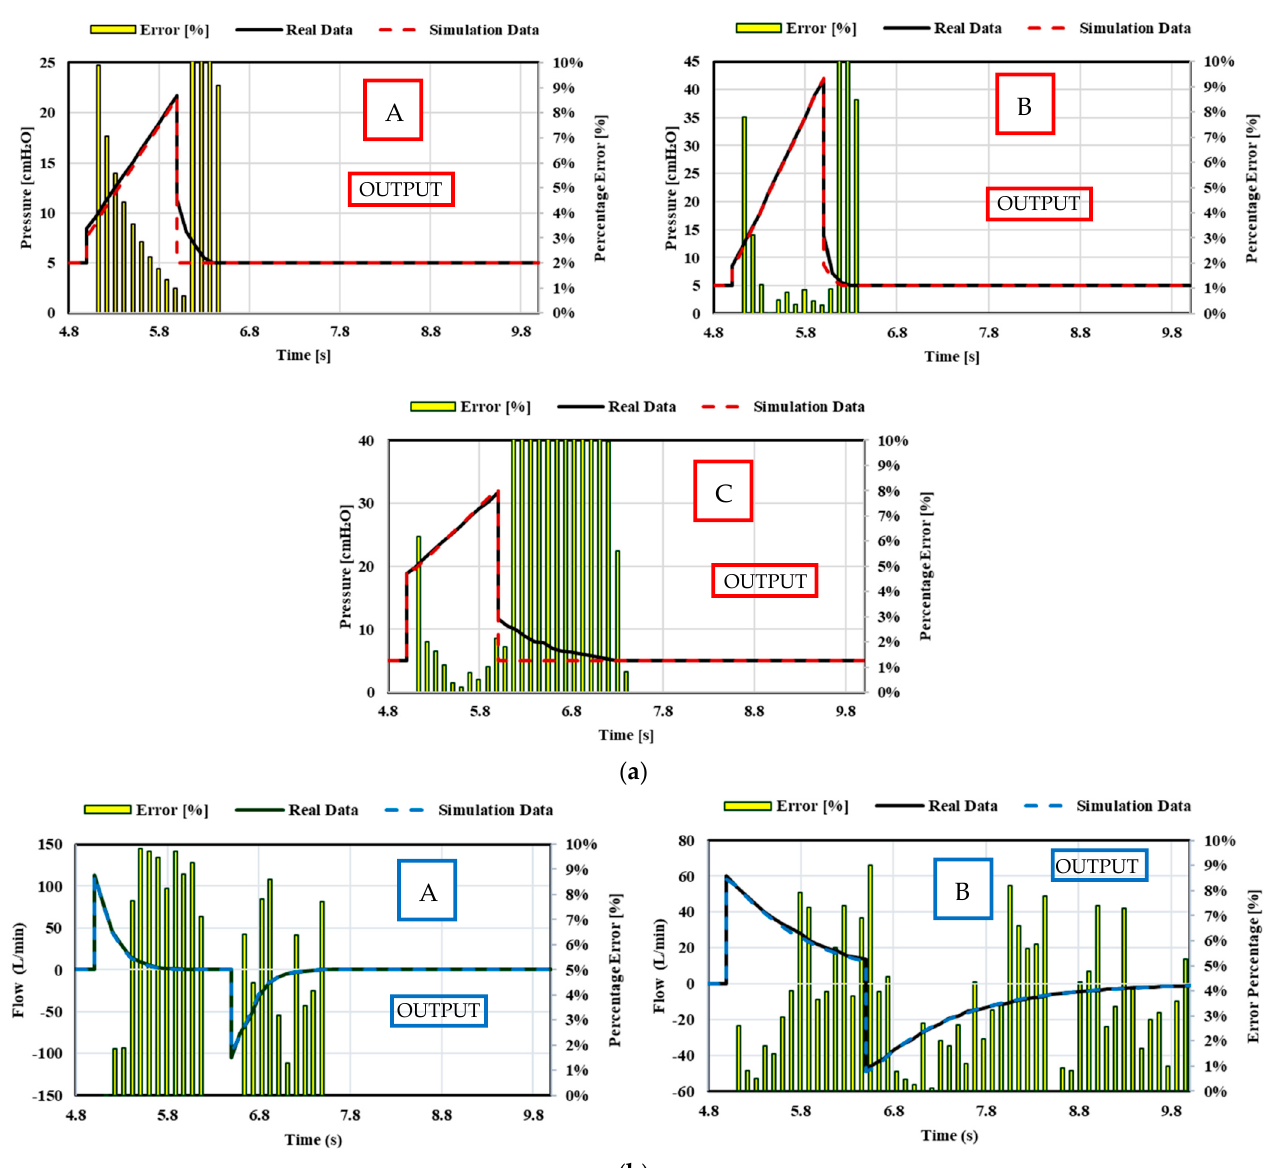
Figure 27. Case 3. Comparison between theoretical real-life data and simulation data for the resistance and compliance changes: ( a ) VC-CMV mode ([A] C RS = 0.05 L/cmH 2 O, R insp = 5 cmH 2 O/L/s, R exp = 15 cmH 2 O/L/s; [B] C RS = 0.02 L/cmH 2 O, R insp = 5 cmH 2 O/L/s, R exp = 15 cmH 2 O/L/s; [C] C RS = 0.05 L/cmH 2 O, R insp/exp = 20 cmH 2 O/L/s); ( b ) PC − CMV mode ([A] C RS = 0.02 L/cmH 2 O, R insp/exp = 10 cmH 2 O/L/s; [B] C RS = 0.05 L/cmH 2 O, R insp/exp = 20 cmH 2 O/L/s).